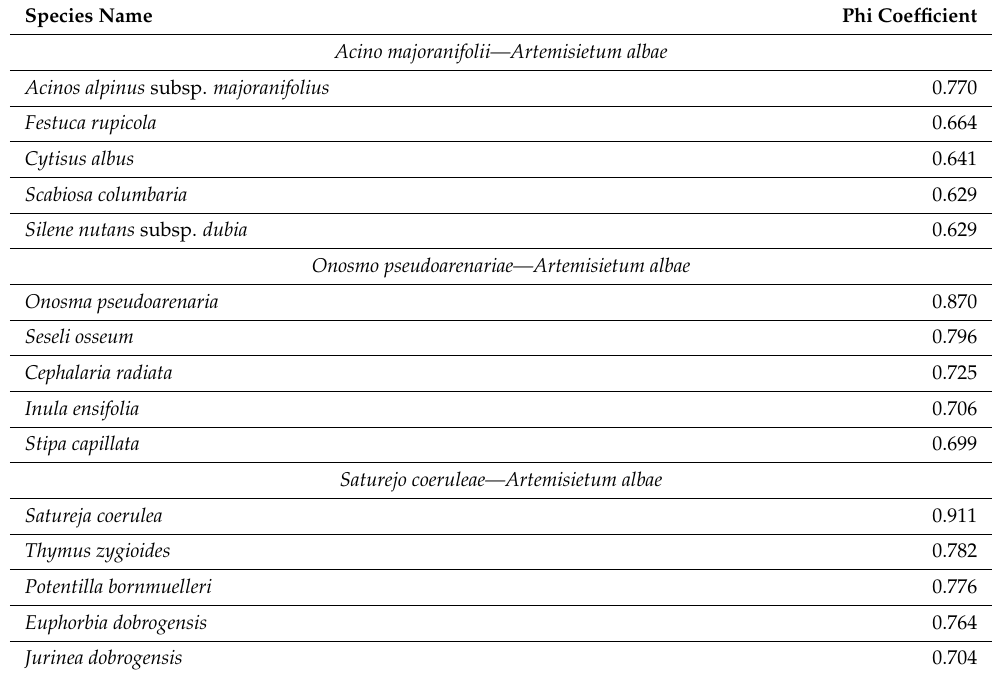
Table 5. Discriminant species best associated with each of the three syntaxa distinguished in the Carpathian and Pontic regions (only the first five species with the highest correlations per group are shown). All coefficients are significant at 0.01% alpha probability.